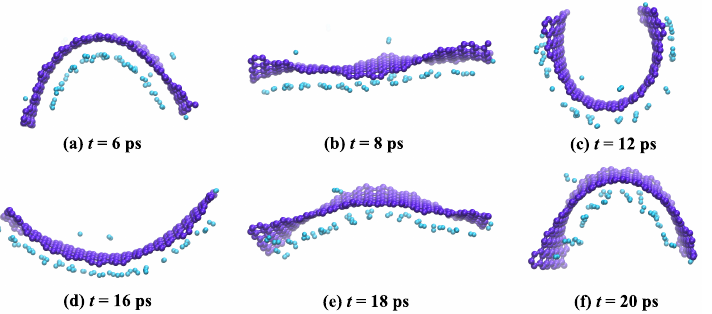
Figure 7. Snapshots of graphene flake with 78 hydrogen atoms during exposure at 77 K for 20 ps. Colors are as in Figure 6.